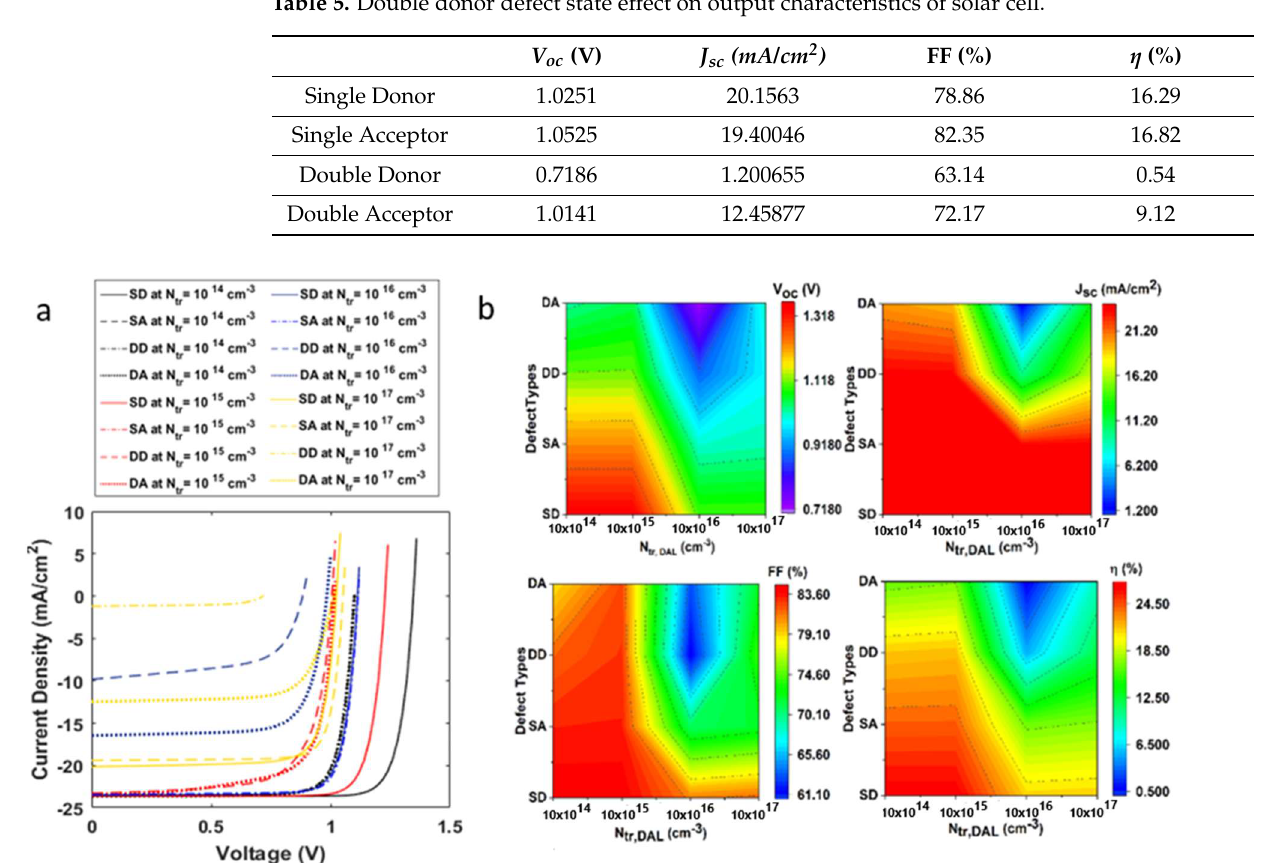
Table 4. Defect state effect on output characteristics of solar cell at trap density 10 (cid:2869)(cid:2874) cm (cid:2879)(cid:2871) .